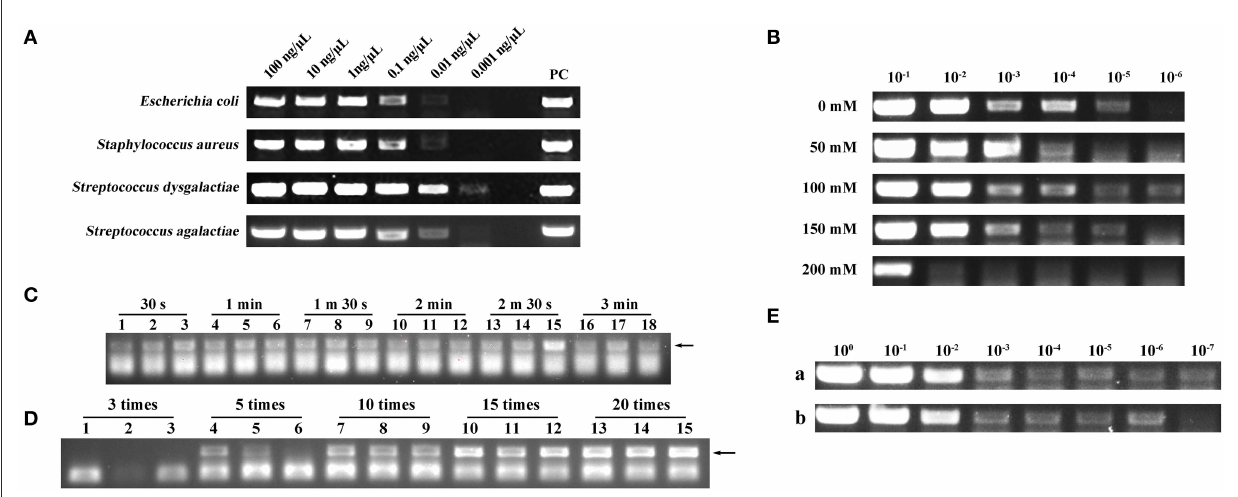
FIGURE2 (A) Deoxyribonucleic acid (DNA) extraction capability assessment of a filter paper. PC represents positive control. (B) Screening of optimal NaCl concentration in lysis. 10 − 1 , 10 − 2 , 10 − 3 , 10 − 4 , 10 − 5 , and 10 − 6 represent the bacterial dilution gradient. Concentrations of NaCl were 0, 50, 100, 150, and 200mM. (C) Screening of optimal lysis number (30s, 1min, 1min 30s, 2min, 2min 30s, and 3min). Each assay was conducted in triplicate. (D) Screening of optimal elution number (3, 5, 10, 15, and 20 times). Each assay was conducted in triplicate. (E) Comparison of nucleic acid extraction ability between the disposable extraction devices (DEDs) and magnetic bead method. (a) Magnetic bead extraction method. (b) Filter paper extraction method. 10 0 , 10 − 1 , 10 − 2 , 10 − 3 , 10 − 4 , 10 − 5 , 10 − 6 , and 10 − 7 represent the bacterial dilution